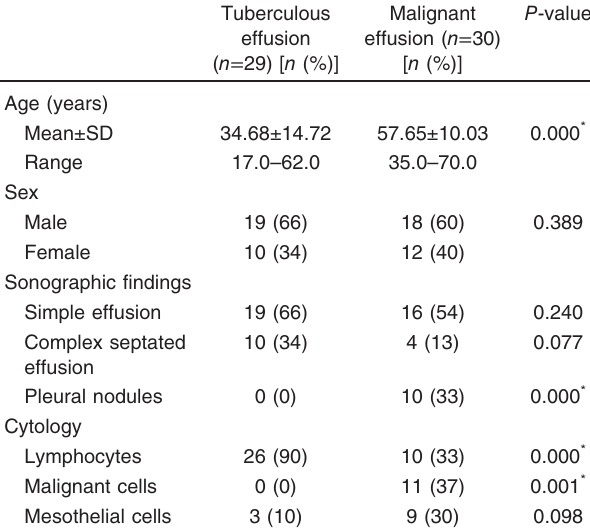
Table 1 Demographic data, sonographic findings, and cytological findings of the studied groups